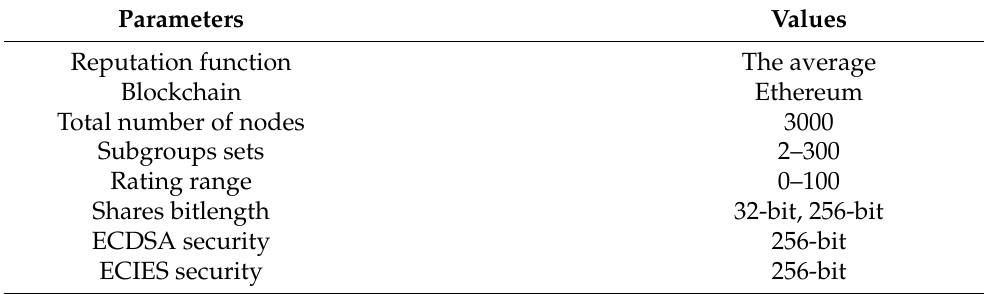
Table 5. Simulation